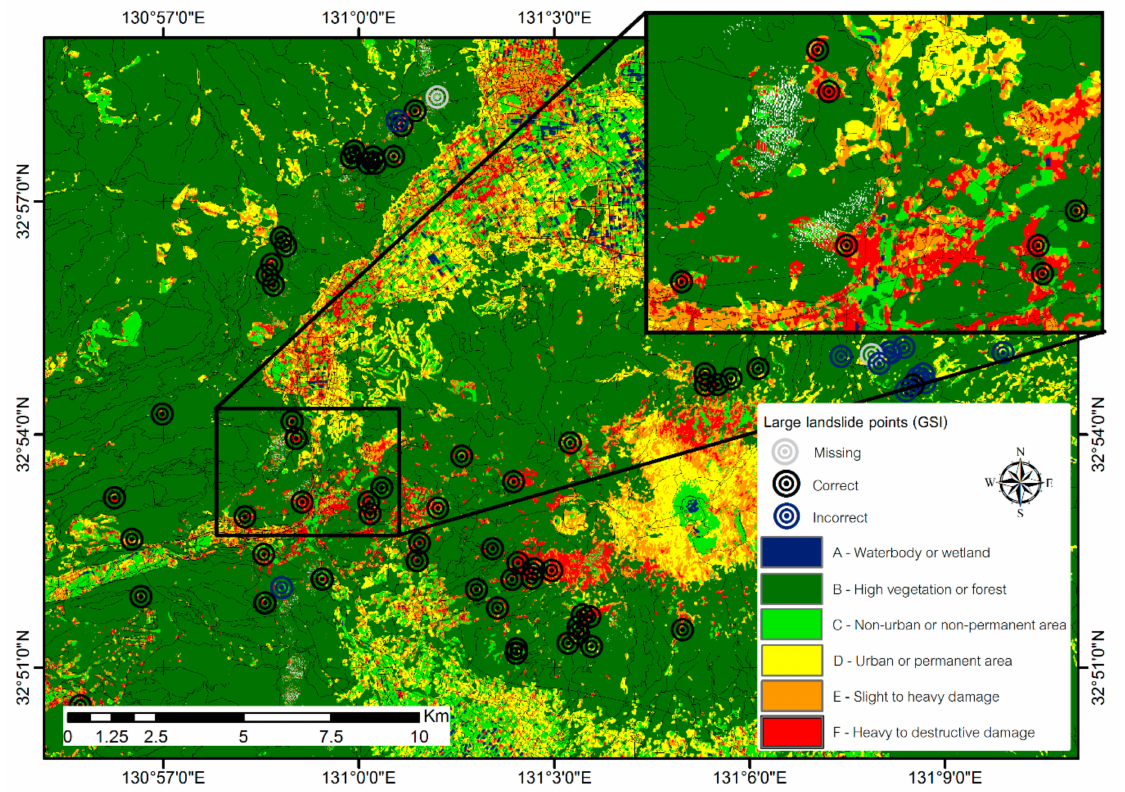
Figure 10. The affected areas and surrounding high vegetation levels where landslides occurred; large landslide locations are from